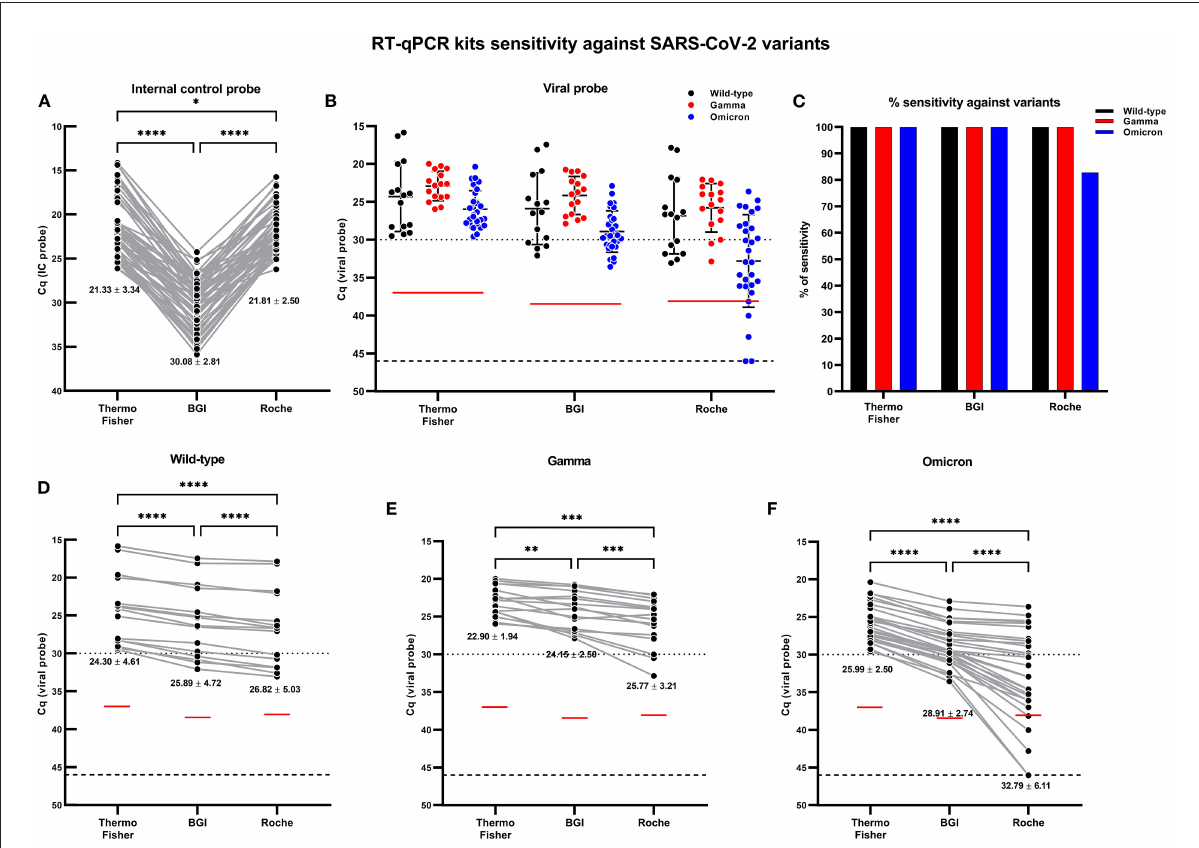
FIGURE6 Comparative analysis of SARS-CoV-2 variants detection from NPS samples using the three RT-qPCR kits. The comparison was made from the same NPS sample loading the optimized volume of total RNA extracted (2 µ l). Each spot for each RT-qPCR kit is a different analyzed sample. For graphs (A,D–F) , the lines connecting the points indicated the paired result obtained from the same sample assessed by the different RT-qPCR kits; the numbers below each group of points represent the mean Cq value, and the standard deviation (mean ± SD). Cq = 46 denotes no amplification (No Cq) and is represented with a broken line. The horizontal red lines on graphs (B,D–F) , indicate the Cq cut-off determined for the viral probe (Figure 4) of each RT-qPCR kit, respectively. (A) Paired Cq analysis for the IC probe (RNase P or β -actin) amplification values obtained by RT-qPCR for each sample assessed. (B) Comparative distribution of Cq values for SARS-CoV-2 variant samples diagnosed by each RT-qPCR kit. (C) RT-qPCR kit sensitivity percentage of RT-qPCR kits against SARS-CoV-2 variants. Paired Cq analysis for the SARS-CoV-2 viral probe (ORF1ab or RdRp) amplification values obtained by RT-qPCR for each sample assessed corresponding to (D) wild-type strain SARS-CoV-2, (E) Gamma variant, and (F) Omicron variant. For statistical analysis, paired two-way ANOVA was applied (60 samples were selected, of which 15, 16, and 29 samples correspond to the wild-type strain, the Gamma variant, and the Omicron variant, respectively). * p < 0.05; ** p < 0.01; *** p < 0.001; **** p <